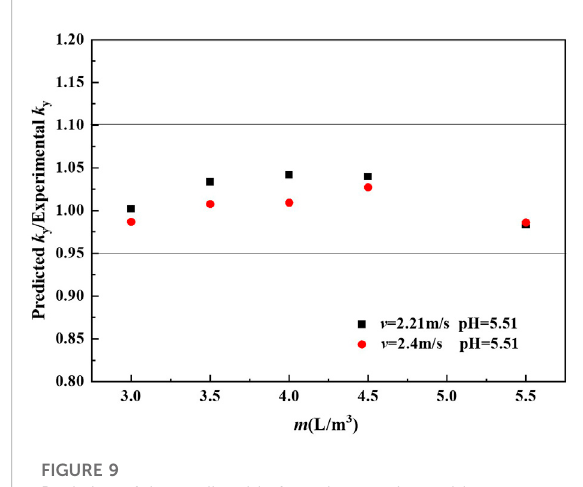
FIGURE 7 Deviation of the predicted k y from the experimental k y at different pH of solution.